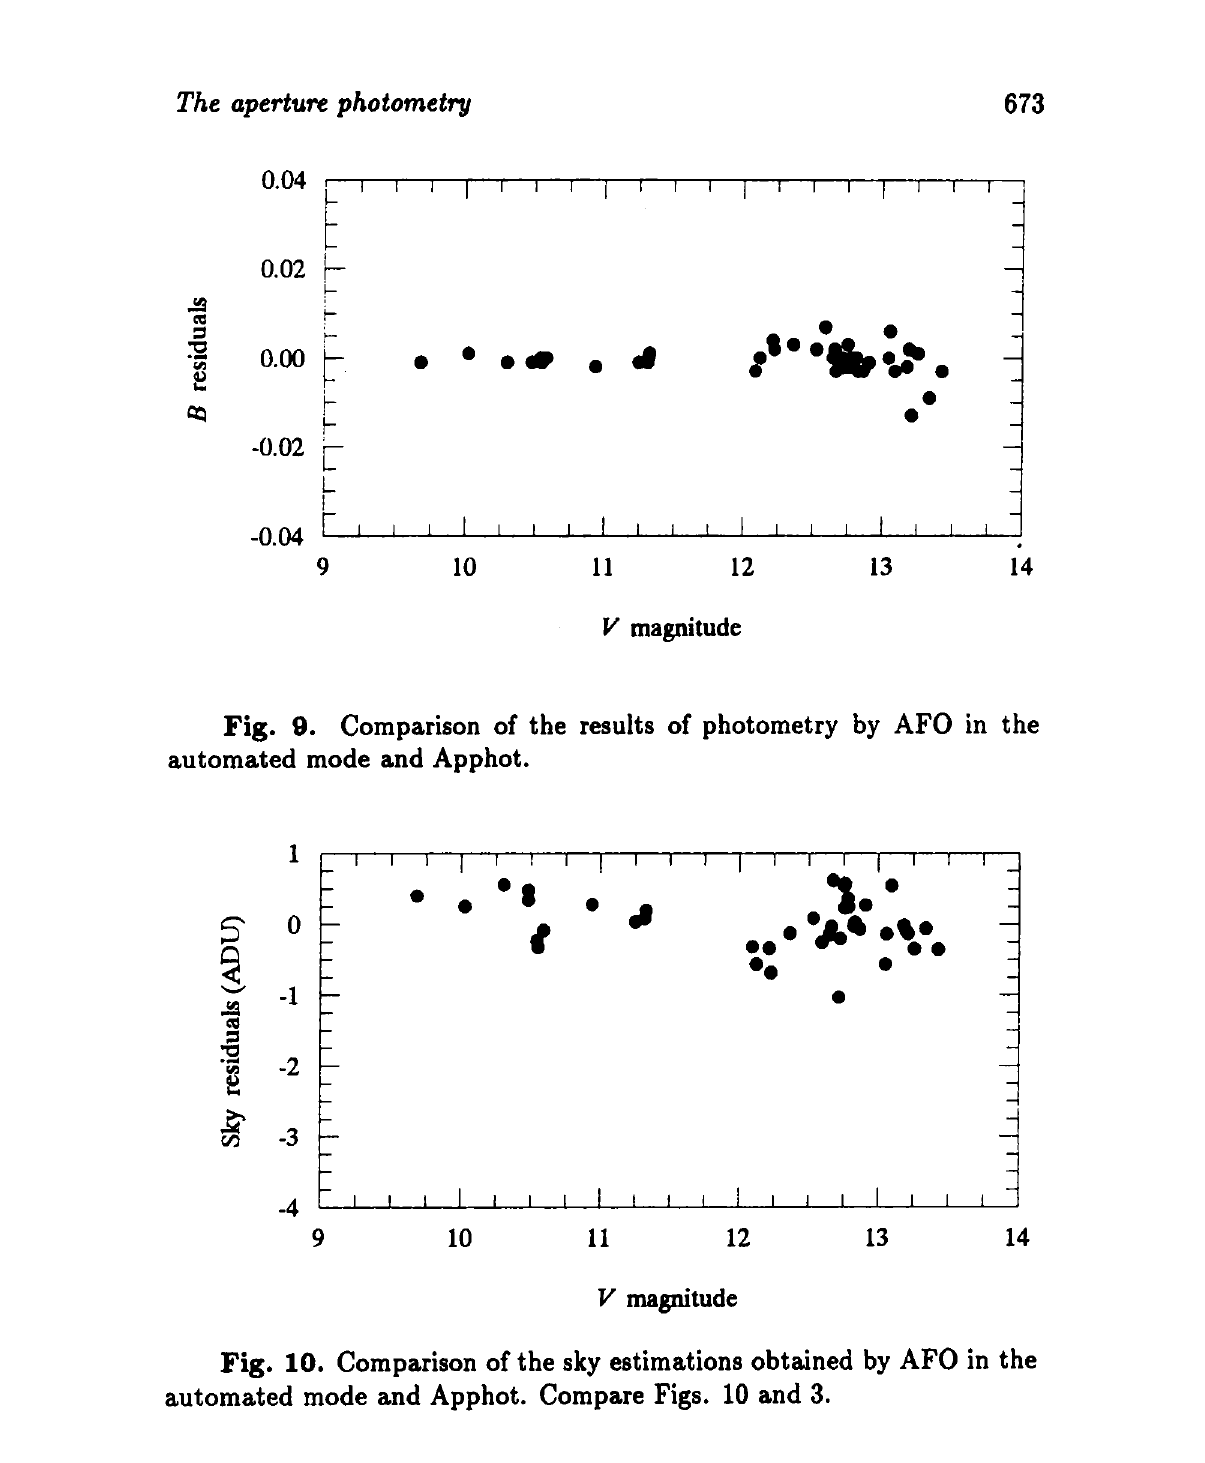
Fig. 10. Comparison of the sky estimations obtained by AFO in the automated mode and Apphot. Compare Figs. 10 and